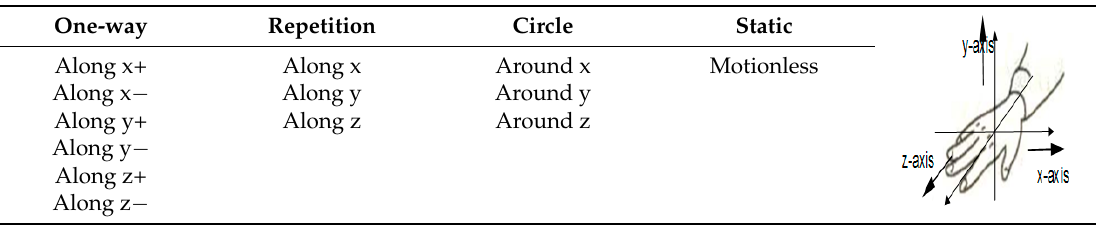
Figure 6. Five typical orientation subclasses: ( a ) palm inward; ( b ) hand upward; ( c ) hand downward; ( d ) palm up; and ( e ) palm down.